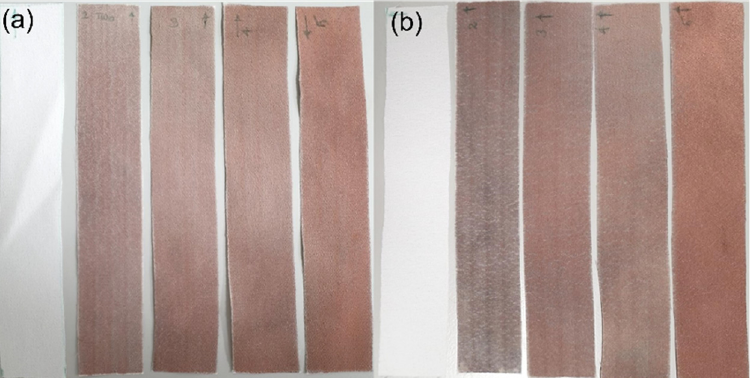
Figure 12. Photograph images of the back side of the metallised textiles printed with the Cu–Ag NP catalyst at different numbers of cycles (From left to right: untreated textile, 2, 3, 4 and 5 printing cycles) in the ( a ) warp; and ( b ) weft directions.